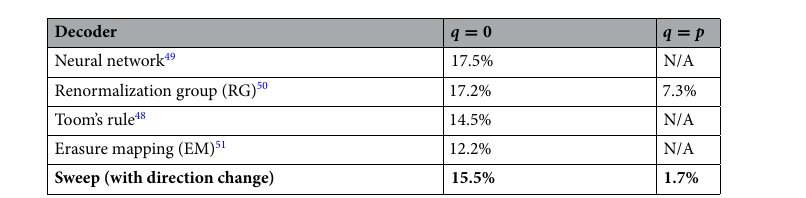
Figure 1. Numerical error threshold estimates for the sweep decoder applied to the toric code on the rhombic dodecahedral lattice. In ( a ), we plot the error threshold p th ( N ) as function of the number of error-correction cycles N , for an error model with equal phase-flip ( p ) and measurement error ( q ) probabilities ( α = q / p = 1 ). The inset shows the data for N = 2 10 , where we use 10 4 Monte Carlo samples for each point. Using the ansatz in Eq. (10), we estimate the sustainable threshold to be p sus ≈ 2.1% . In ( b ), we plot p sus for error models with different values of α , where we approximate p sus ≈ p th ( 2 10 ) .